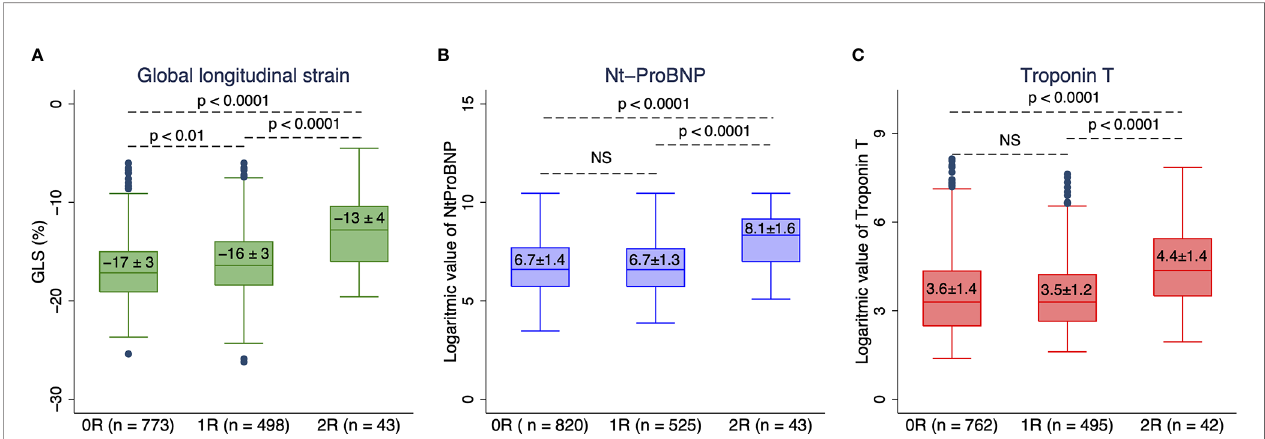
FIGURE 1 | Boxplots comparing (A) echocardiographic global longitudinal strain magnitude (GLS), (B) plasma NT-ProBNP level, and (C) plasma high-sensitivity troponin T level between three biopsy groups (0R, no rejection; 1R, mild rejection; and ≥ 2R, severe treatment demanding rejection). NS, not signi fi